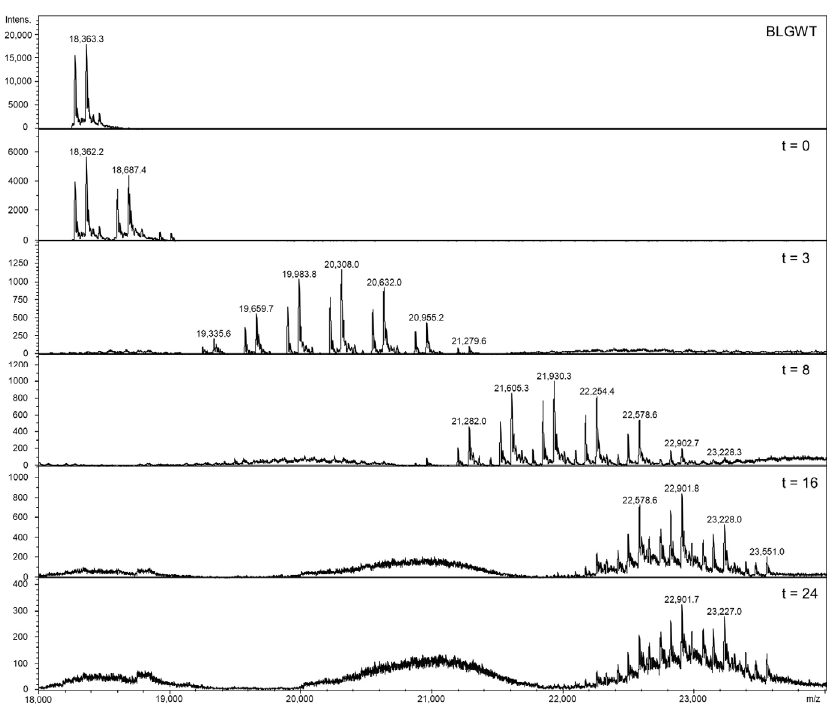
Figure 3. Deconvoluted spectra of BLGWT and the conjugates at different time intervals. A clear shift of 324.1 Da is visible at each time interval, which can be attributed to an increase of one lactose residue (342.1 Da) and the loss of water (18.01 Da) during Maillardation. Signal intensities decrease with increasing lactosylation levels. See Supplementary Materials Table S4 for accurate masses. The protein BLG has 19 potential lactosylation sites, namely the N-terminal leucine, 15 lysine and three arginine residues. A range of lactose units per molecule was observed between incubation times of 3 to 16 h, while heterogenicity lessened after 16 h. A plateau was reached after 8 to 16 h incubation, when 16 sites were lactosylated. Figure 4 shows the distribution of lactose units per BLG molecule over time.